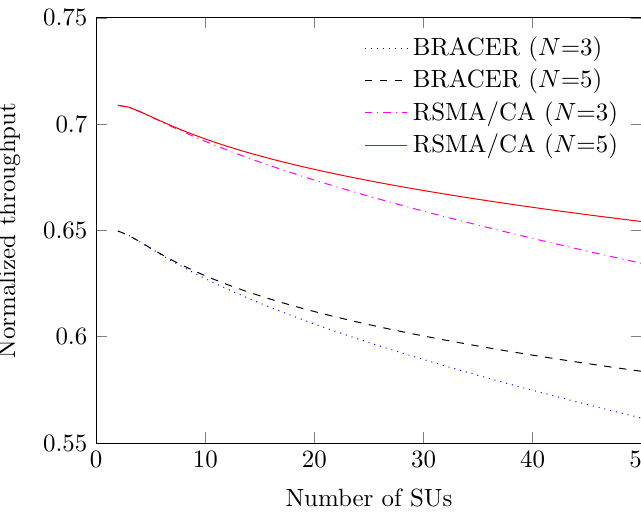
Figure 11. Normalized throughput vs. number of